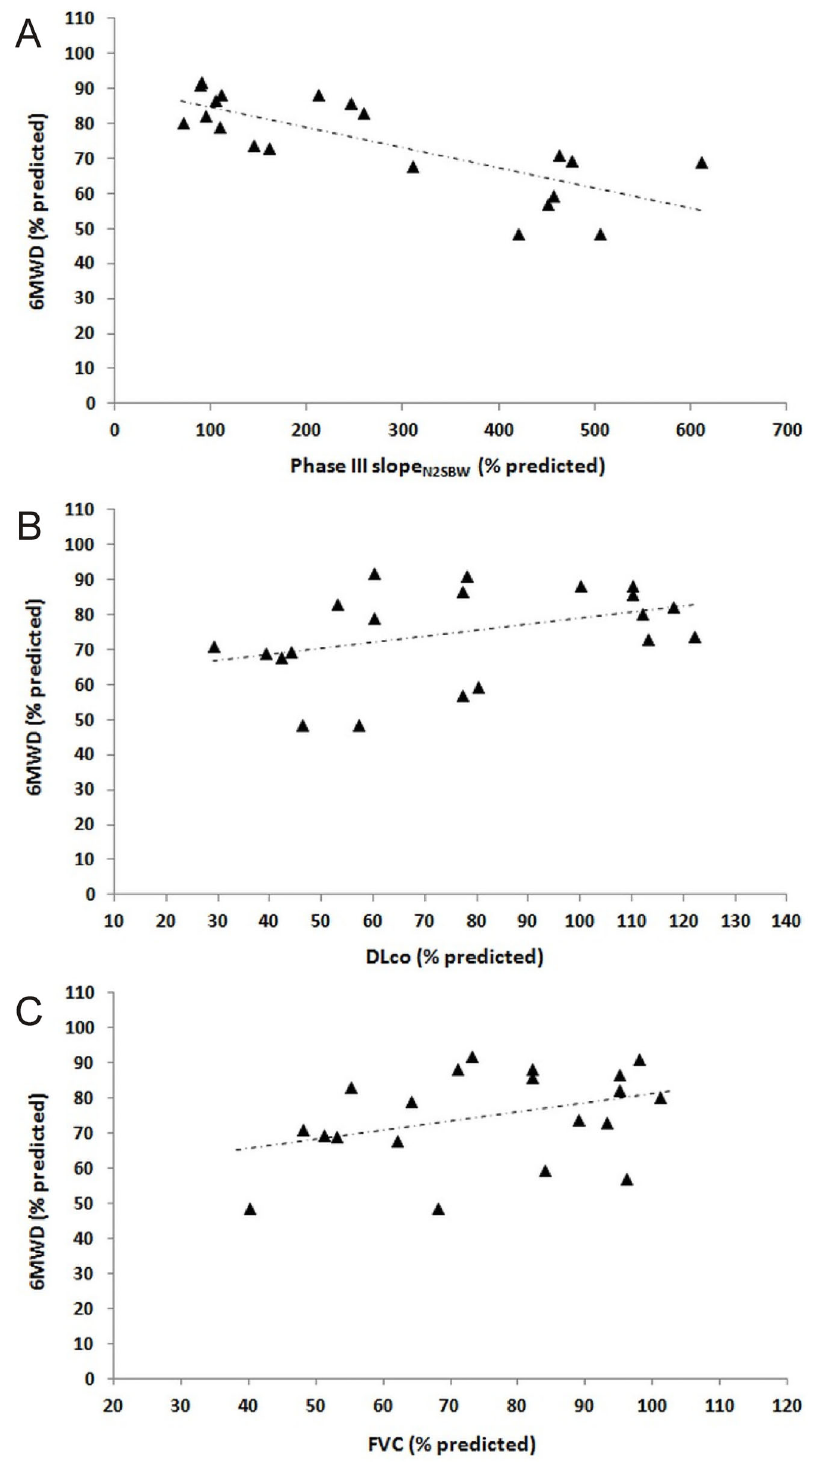
Figure 1. A , Relationship of the 6-min walking distance (6MWD, % predicted) with the phase III slope of the nitrogen single-breath washout (phase III slope N2SBW ) (r= – 0.753, P o 0.0001), B , diffusing capacity for carbon monoxide (DLco) (r=0.398, P=0.011), and C , forced vital capacity (FVC) (r=0.466,